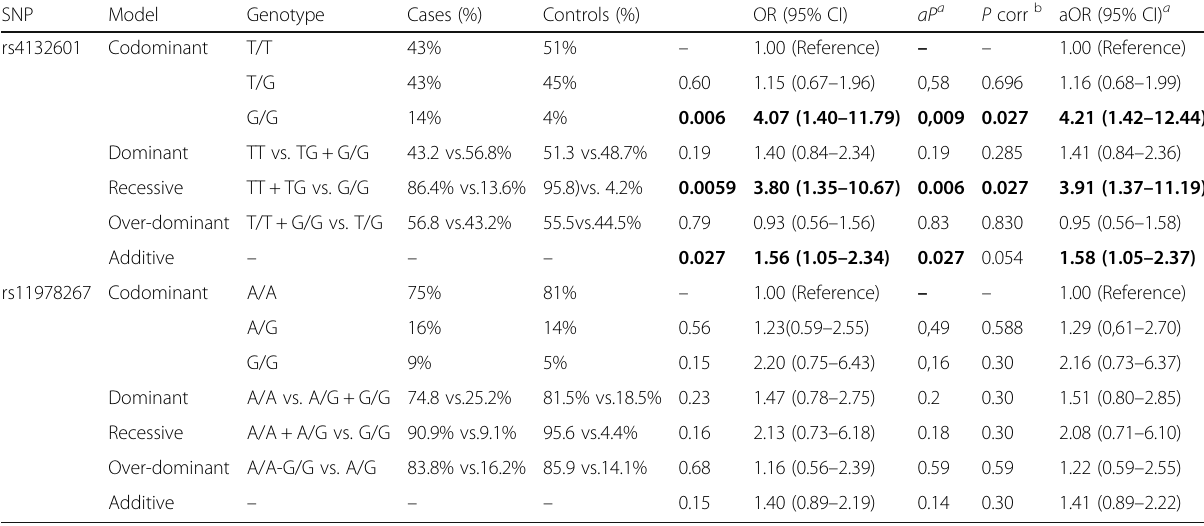
Table 3 Genotypic distributions of the rs4132601 T/G and rs11978267 A/G variants between cases and controls according to different models of genetic transmission